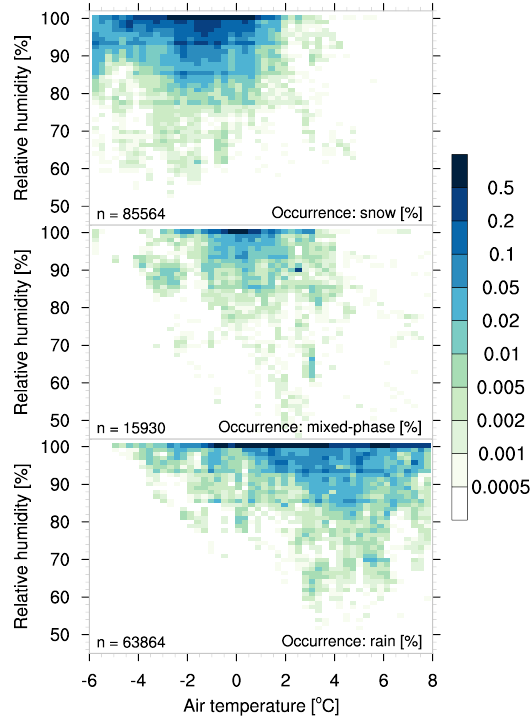
Figure 3. Two-dimensional histogram shows relative occurrence (%) for each PP (top: snow; middle: mixed phase; bottom: rain) after manual PP distinction from OceanRAIN RSM data set of RV Polarstern . n denotes the number of minutes used per PP (165632 in